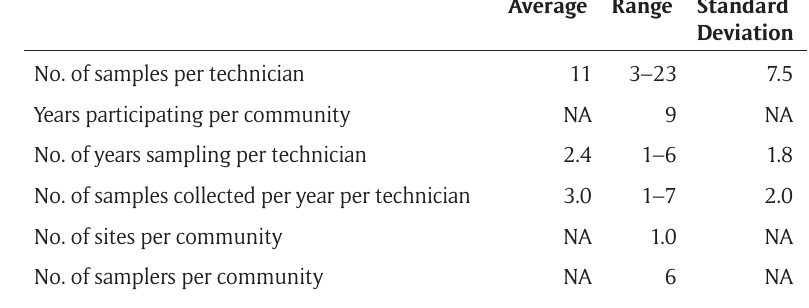
Table 3: Community participation in ION at Pilot Station over the years 2006–2014. [NA = not